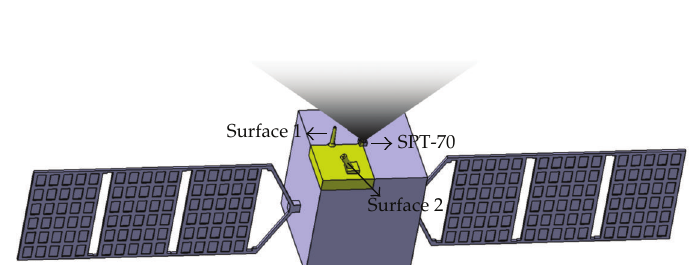
Figure 2: Spacecraft